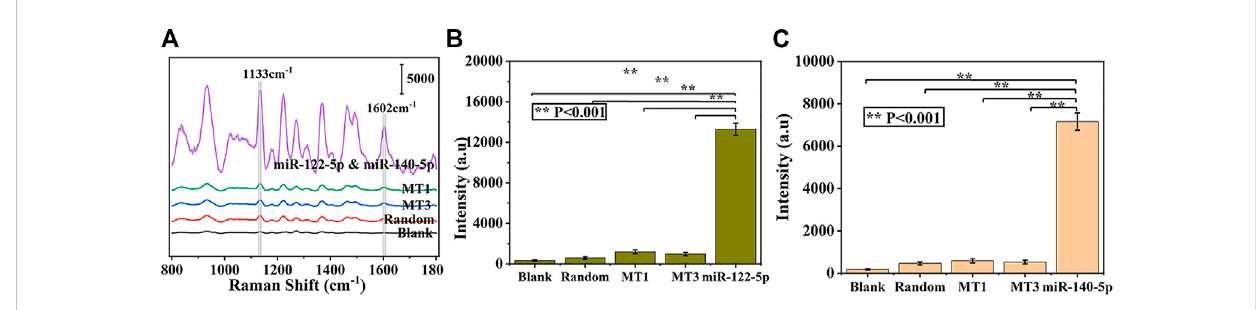
FIGURE 6 Speci fi city of the proposed biosensor, (A) and corresponding histogram of SERS intensities at 1,133 cm − 1 (B) and 1,602 cm − 1 (C) from three interference and blank control groups, respectively.